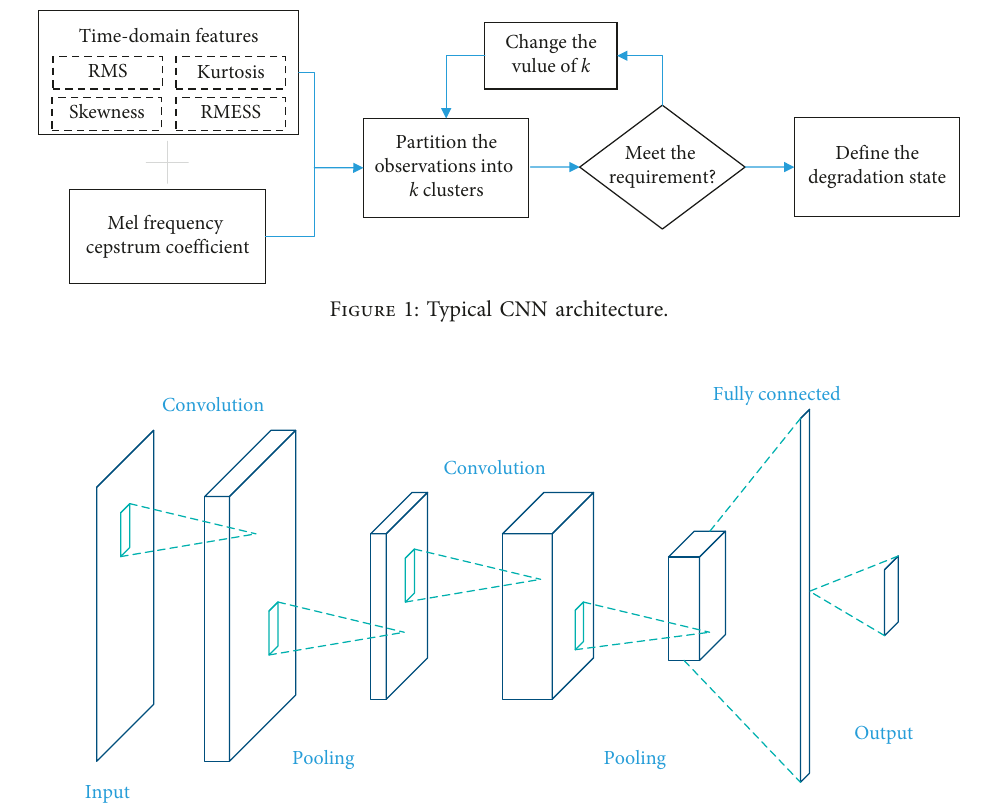
Figure 2: Typical CNN architecture.